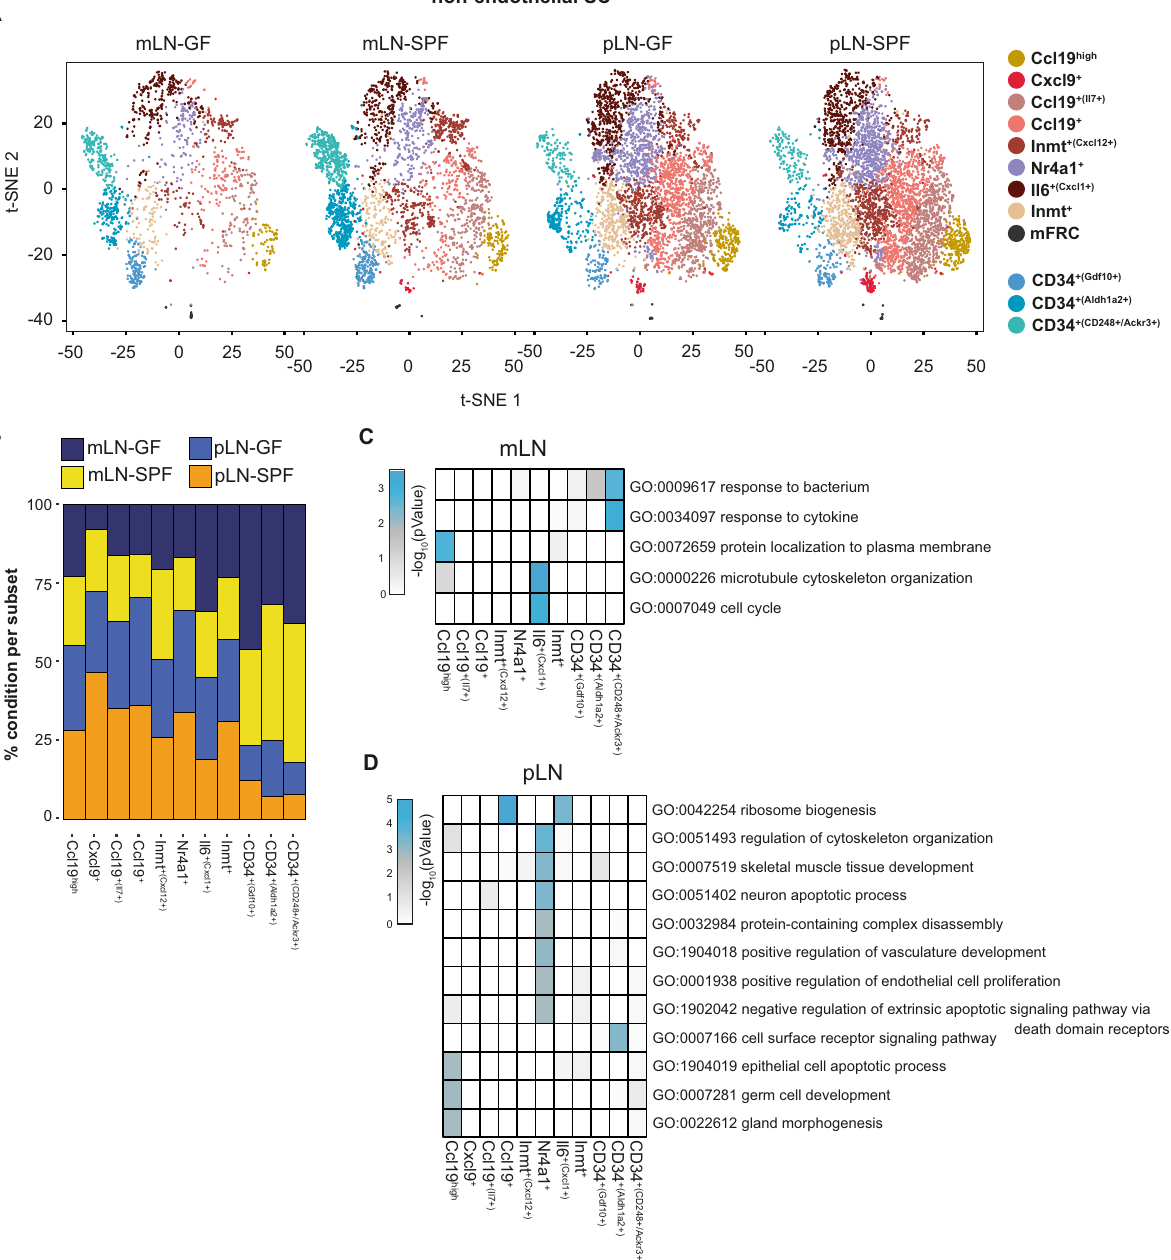
mLN-SPF, pLN-GF, or pLN-SPF condition. C GO analysis of biological processes of upregulatedDEGsidenti fi edbetweenSPF-mLNandGF-mLNcondition(enrichment analysisofGOtermscalculatedwithFisher´sexacttest). D GOanalysisofbiological processes of DEGs identi fi ed between SPF-pLN and GF-pLN condition (enrichment analysisofGOtermscalculatedwithFisher ’ sexacttest).BECbloodendothelialcell, DEGdifferentiallyexpressedgene, FRC fi broblasticreticularstromalcell, GF germ- free, GO gene ontology, LEC lymphatic endothelial cell, mLN mesenteric lymph node, pLN peripheral skin-draining lymph node, PvC perivascular cell, SC stromal cell, SPF speci fi c